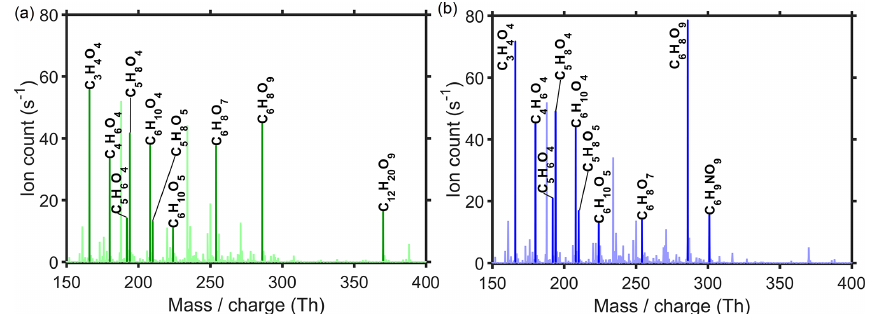
Figure 1. Two example 10min average spectra showing the largest product peaks that were all observed within the mass range 150–400Th. Panel (a) shows a spectrum without NO x , while in panel (b) NO x concentration was approximately 9ppb. Ten of the biggest product peaks are highlighted with a darker colour and labelled with their chemical composition. All products were detected as cluster with NO − of which is included in the masses shown in the x